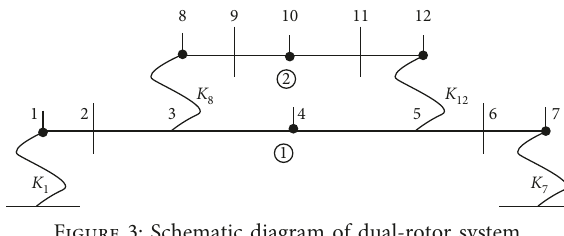
Figure 3: Schematic diagram of dual-rotor